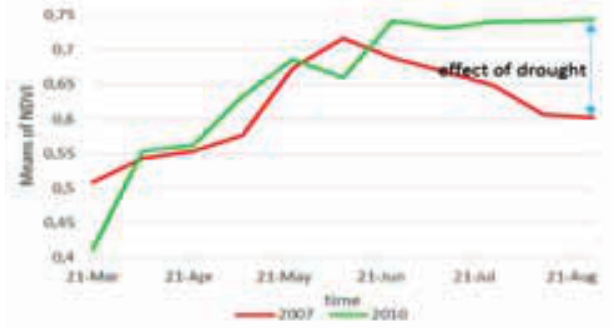
Figure 3. Average NDVI values in a wet and a dry